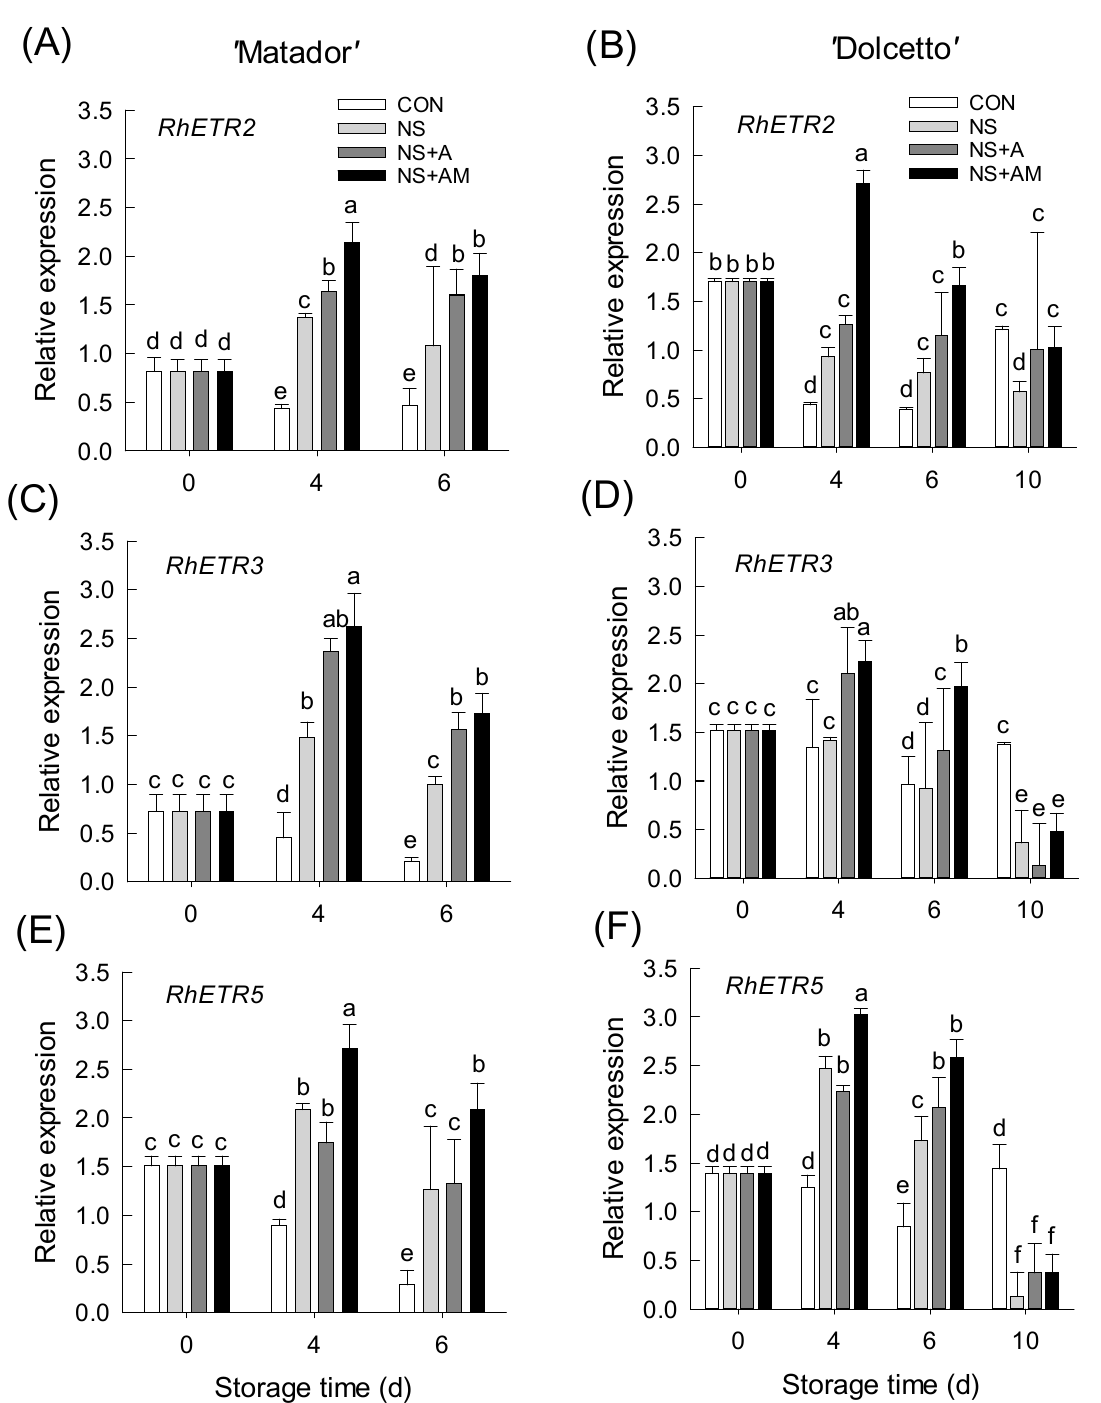
Figure 5. Expression levels of RhETR2 , RhETR3 , and RhETR5 in ‘Matador’ ( A , C , E ) and ‘Dolcetto’ ( B , D , F ) cut roses. mRNA levels of three receptor genes were detected in petals on day 0 (before ethylene treatment) and on days 4, 6, and 10 after ethylene treatment. CON, control flowers were held in DW; NS, cut roses were treated with nano silver; NS+A, cut roses were treated with NS and AIB; NS+AM, cut roses were treated with NS, AIB, and 1-MCP. All cut roses were exposed to ethylene (2 µ L L − 1 ) for 24 h at 25 ± 1 ◦ C under dark conditions. Different letters above bars show statistically significant differences among treatments at p < 0.05 based on DMRT. Vertical bars indicate SE of the means ( n =